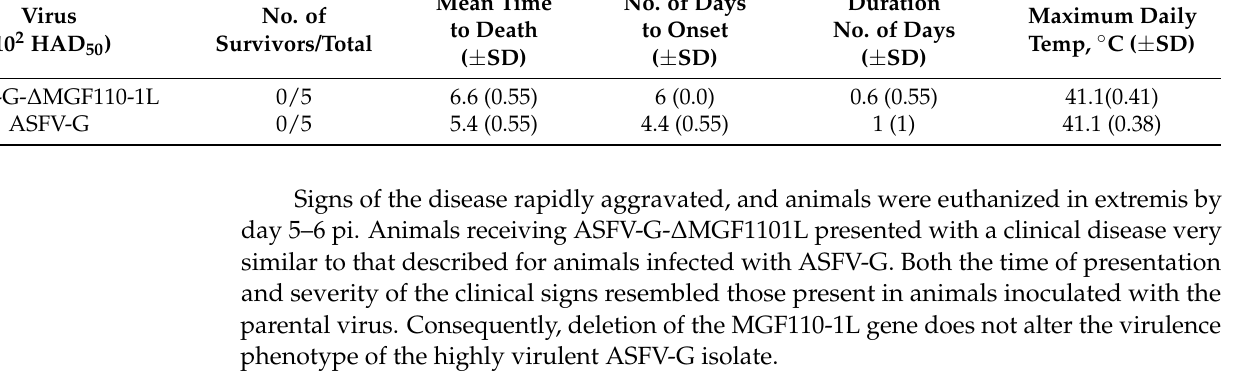
Table 1. Swine survival and fever response following infection with ASFV-G- ∆ MGF110-1L and parental ASFV-G. Virus (10 2 HAD 50 )